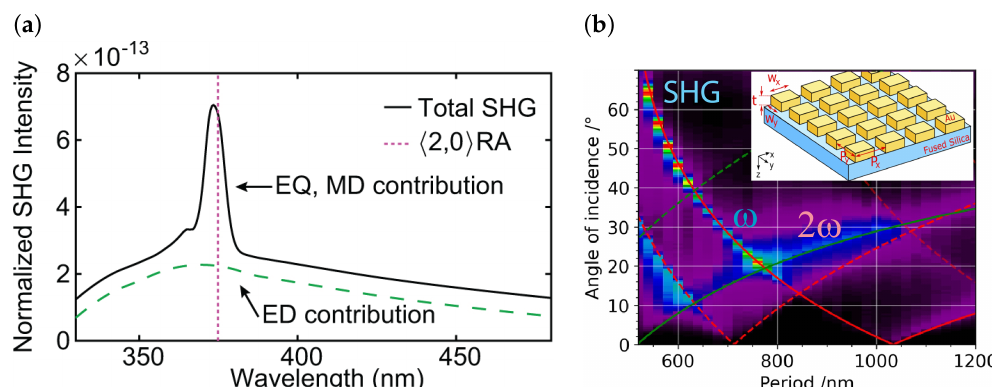
Figure 6. ( a ) Relative strength of the second harmonic generation in the nanoparticle lattice. The second harmonic generation spectrum shows a narrow resonance peak at 375 nm with an x -polarized incident electric field, corresponding to electric-quadrupole- and magnetic-dipole-multipole reso- nance at 750 nm. The (2,0)-order Rayleigh anomaly wavelength is denoted by the vertical dotted line, and the dashed line represents the electric dipole contribution at the fundamental wavelength to the second harmonic generation. ( b ) Measured power of the second harmonic generation stemming from the transmission into the 0th diffraction order. It is normalized with respect to the plot’s absolute max- imum. The overlaid lines demonstrate the Rayleigh anomaly for the diffraction order | m | = 1, with solid lines denoting conditions in air and dashed lines in fused silica. The corresponding wavelengths are represented by red (pump λ ω = 1032 nm) and green (second harmonic λ 2 ω = 516 nm) lines. The Rayleigh anomaly with | m | = 2 is responsible for the partially visible branches at larger periods.